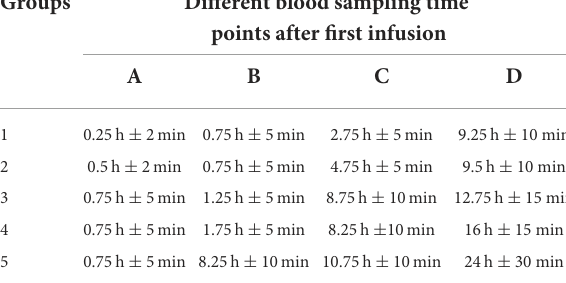
TABLE 1 Blood sampling time points. Groups Different blood sampling